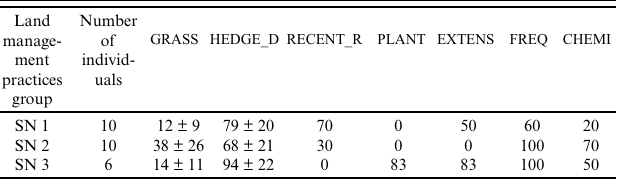
Table 3. Descriptive statistics for the three types of semi-natural areas management practices identified for typology 2 (mean ± SD for GRASS and HEDGE_D; % of farmers in each group with the identified practice for the other indicators). See Table 1 for definitions of variable codes.